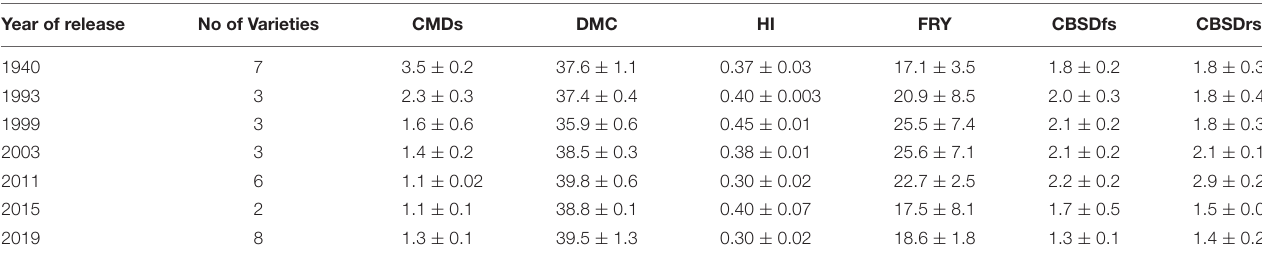
CMDi, cassava mosaic disease incidence at 6 months after planting; CMDs, cassava mosaic disease severity at 6 months after planting; CBSDfi, cassava brown streak disease foliar incidence at 6 months after planting; CBSDfs, cassava brown streak disease foliar severity at 6 months after planting; CBSDri, cassava brown streak disease root incidence at 12 months after planting; CBSDrs, cassava brown streak disease root severity at 12 months after planting; DMC, root dry matter content; HI, Harvest index; FRY, Fresh root yield; RSI, rank summation index. BLUPs for disease traits (CMD and CBSD) based only on data from Namulonge and Serere owing to low disease pressure at Loro. Genotypes were ranked based on their BLUP values for each trait. TABLE 4 | Means for cassava traits selected for between 1940 and 2019 in